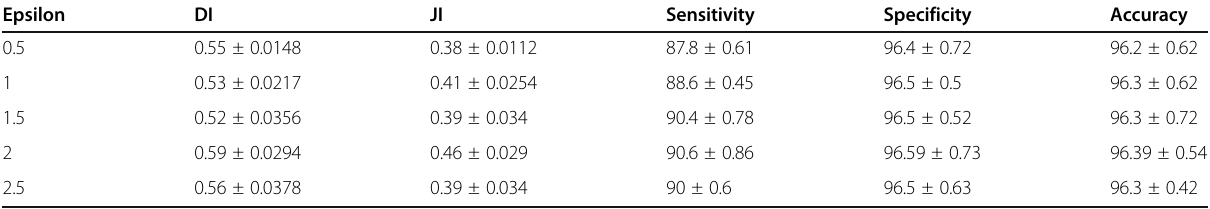
Table 1 Average and SD values of similarity measures between ground truth and segmented results ( n = 40) Epsilon DI JI Sensitivity Specificity Accuracy